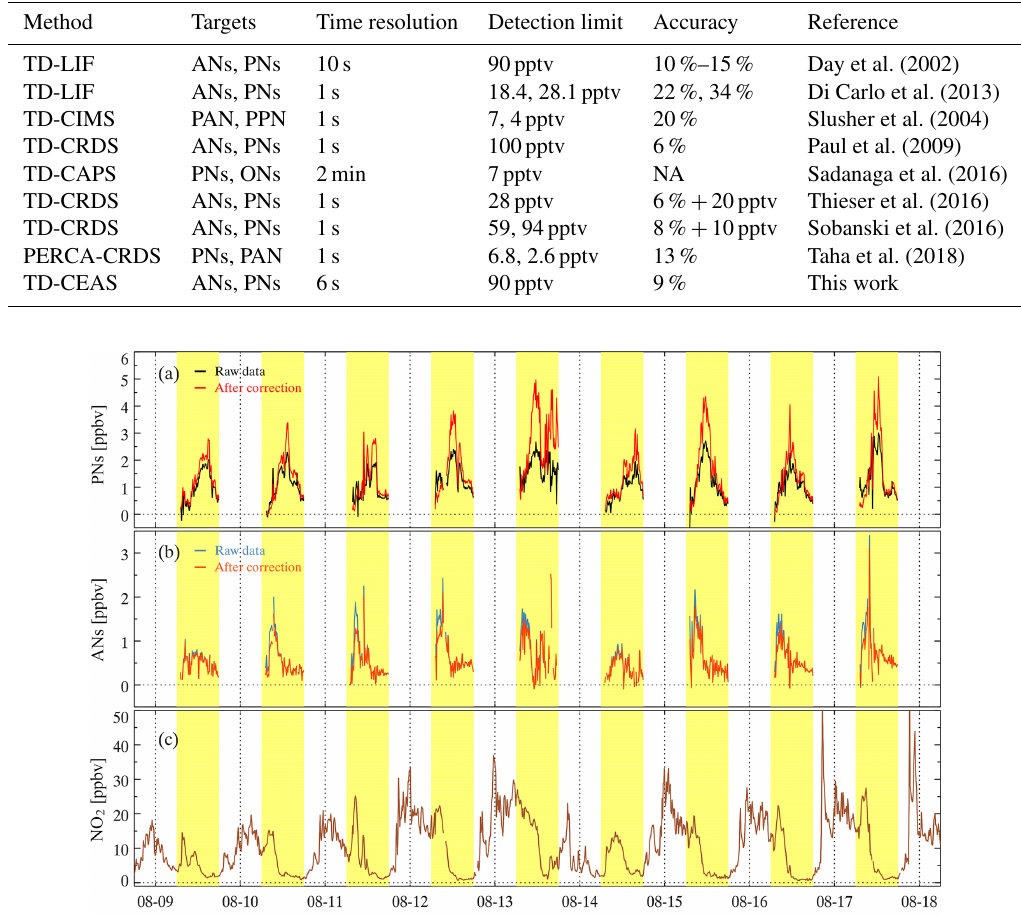
Figure 12. Time series of the observed mixing ratios of PNs, ANs, and NO 2 during ozone pollution from the CHOOSE campaign in 2019. The yellow regions indicate the daytime period. (a) The black lines represent the raw measurements of PNs, and the red lines are the corrected measurements of PNs according to the lookup table. (b) The blue lines represent the raw measurements of ANs, and the orange lines are the corrected measurements of ANs according to the lookup tables. (c) Measurements of NO 2 in the reference channel.